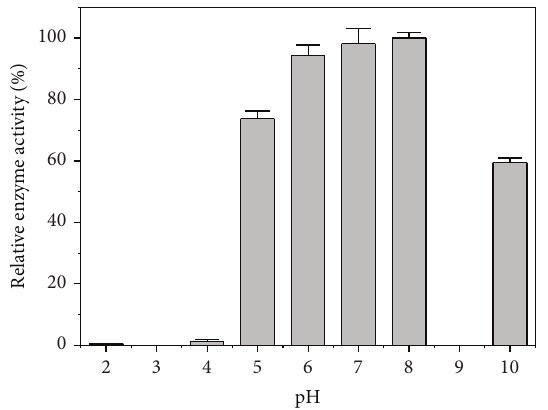
Figure 4: Time-course of cell growth ( e ) and xanthan lyase activity ( ◼ ) when Microbacterium sp. XT11 was cultured in 0.3% xanthan medium at 30 ∘ C and shaking at